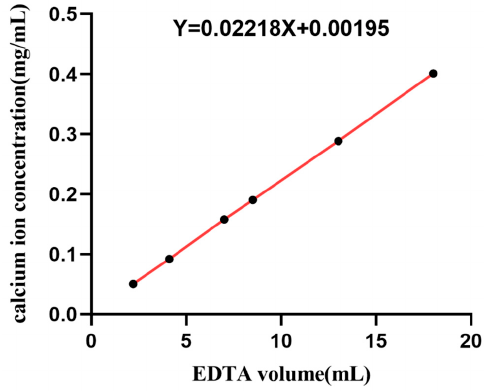
Figure 3. Standard curve of calcium ion concentration. Table 1. Determination and calculation results of calcium content in fish scales.